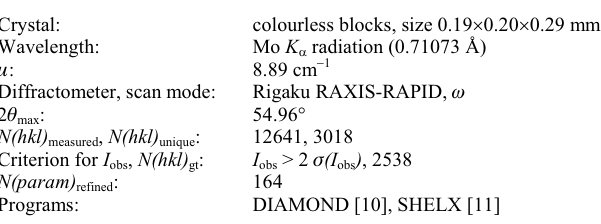
Table 1. Data collection and handling.